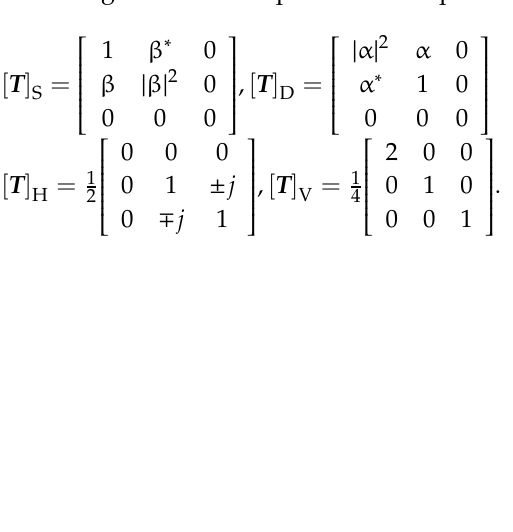
indicates the ensemble averaging.